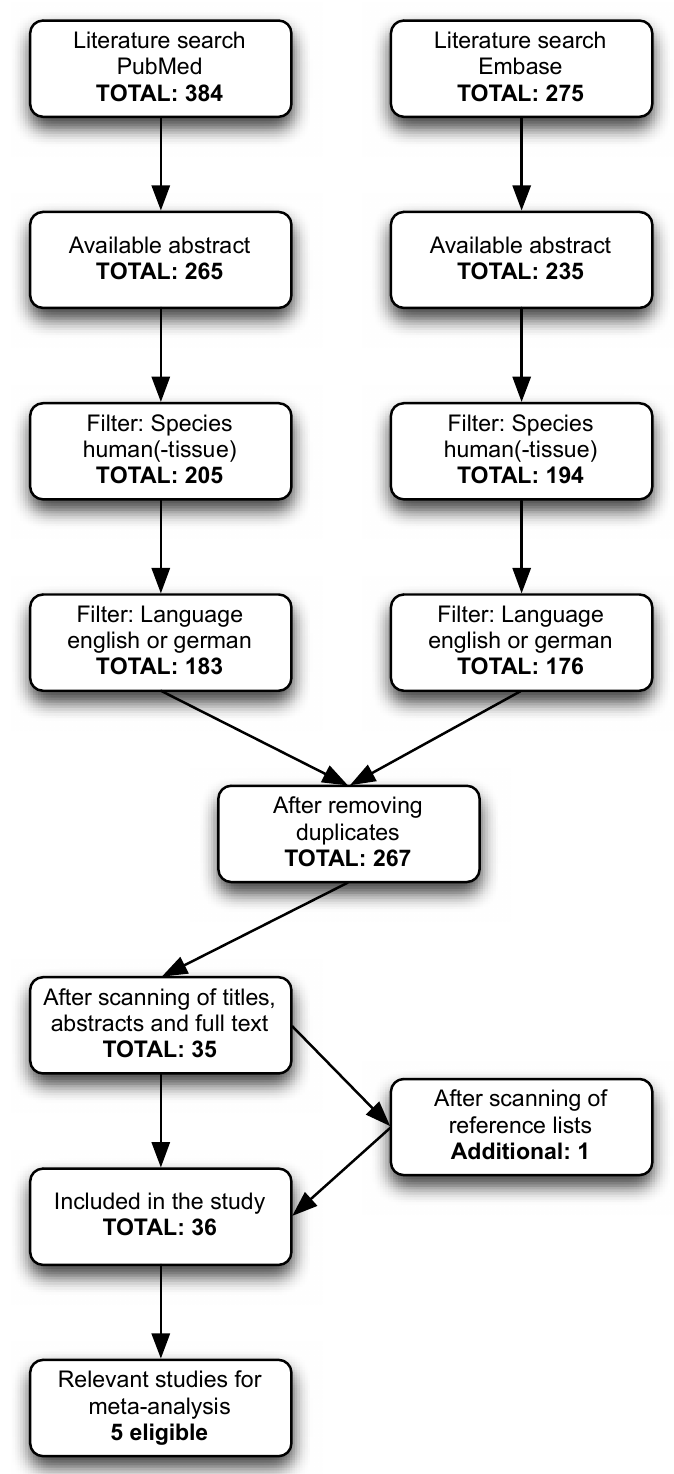
Figure 1. Flow diagram (according to PRISMA) showing the selection process for inclusion of studies from PubMed and Embase.